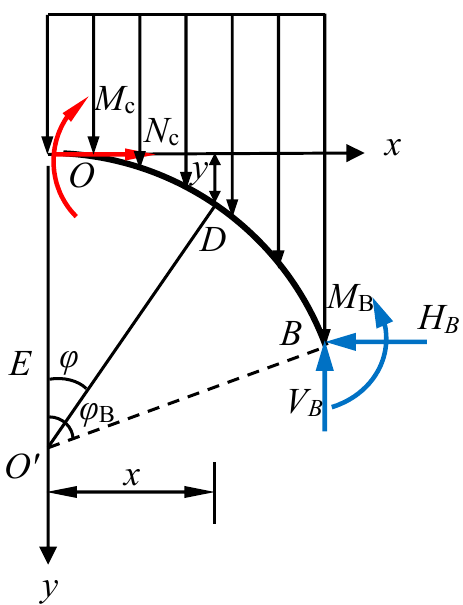
Figure 5. Force diagram of the right half-arch ring.